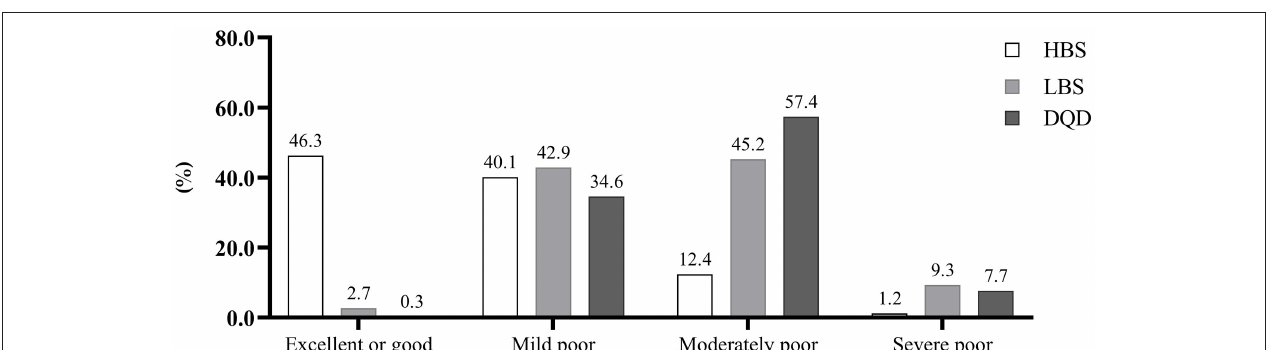
FIGURE 2 | Distributions of HBS, LBS, and DQD among lactating women.